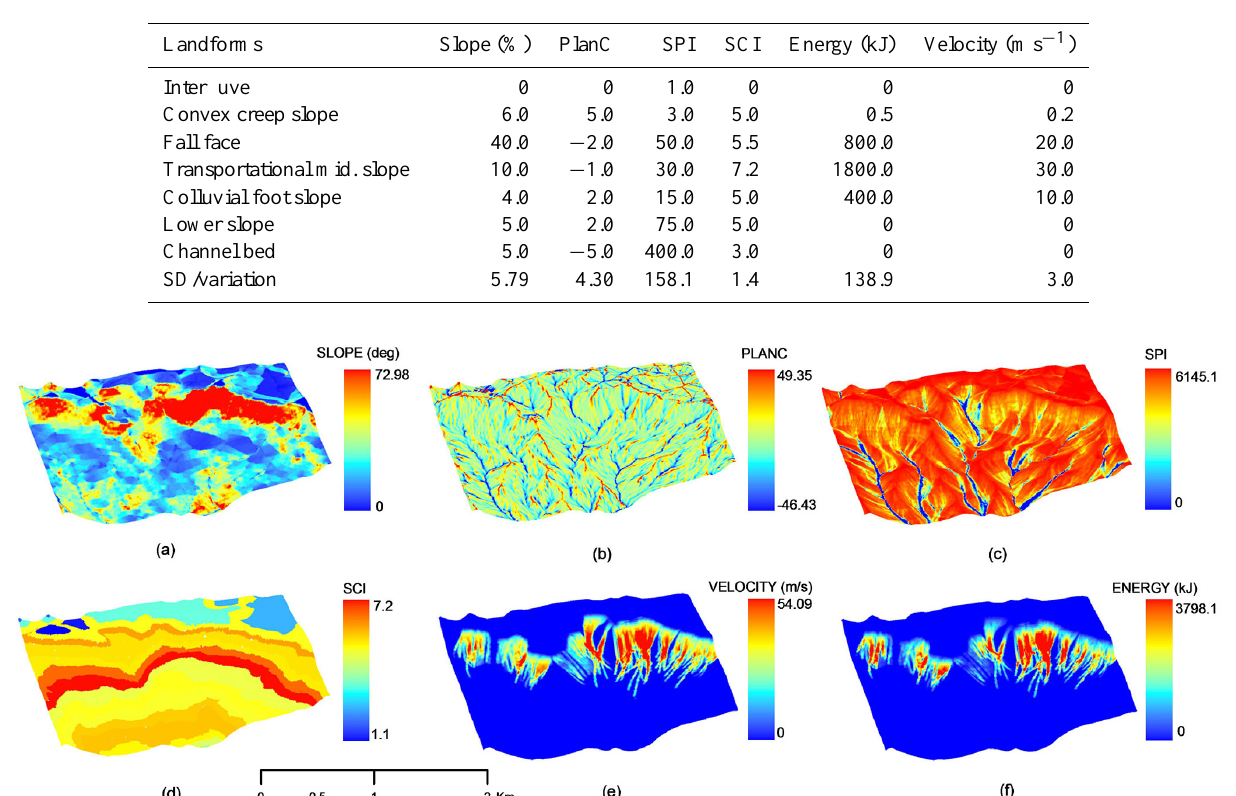
Table 2. Class centers for each morphometric variable (SD, standard deviation; PlanC, plan curvature; SPI, stream power index; SCI, shape complexity index).